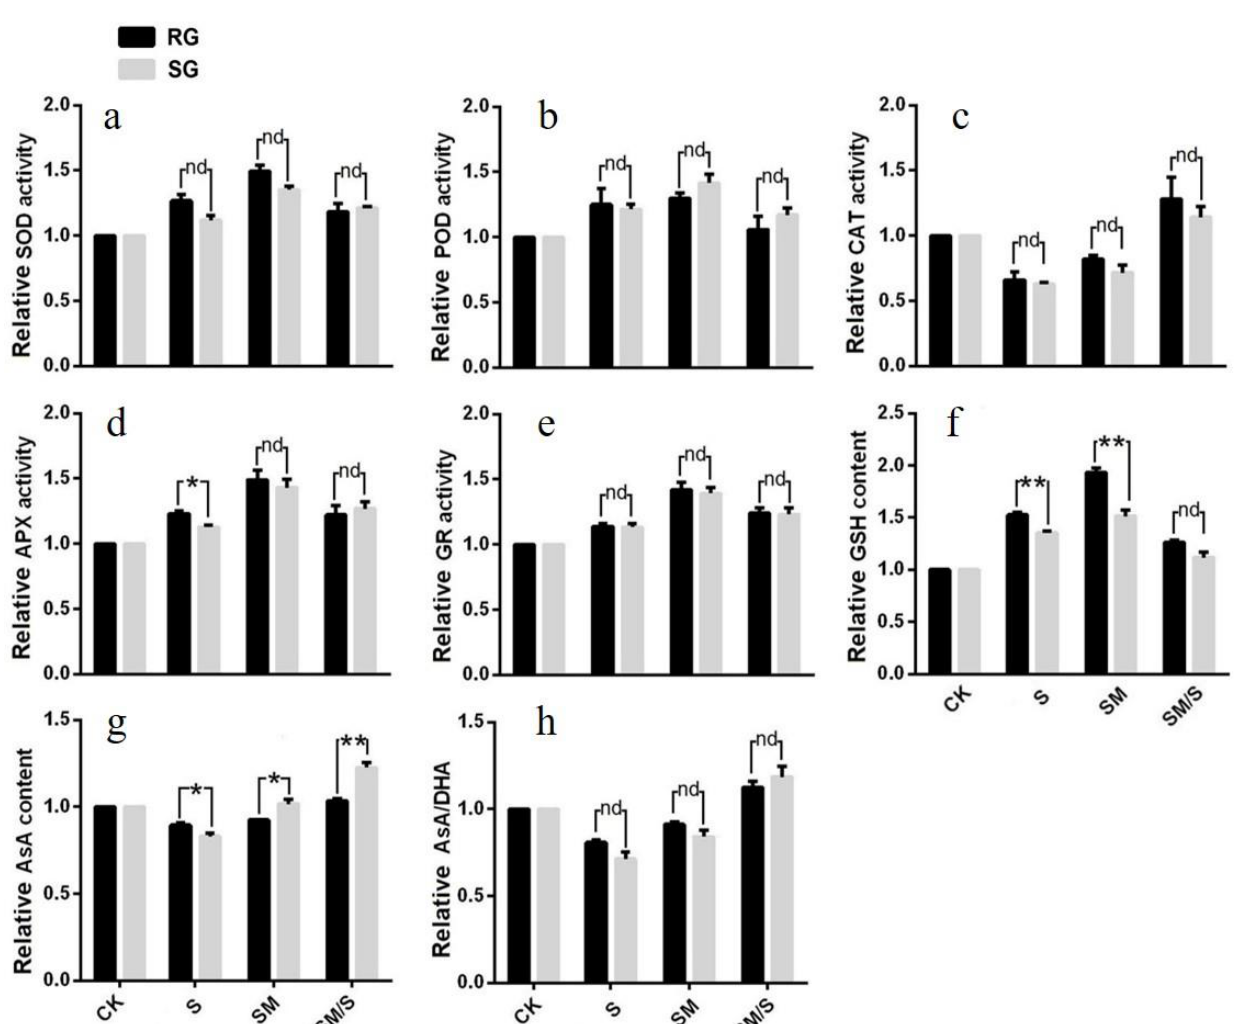
Figure 3. Comparison of antioxidant systems including relative SOD activity ( a ), relative POD activity ( b ), relative CAT activity ( c ), relative APX activity ( d ), relative GR activity ( e ), relative GSH activity ( f ), relative AsA activity ( g ), and relative AsA/DHA ( h ) between salt-resistant and salt-sensitive tomato seedlings under salt stress. All the indices are normalized to CK. RG: salt-resistant genotype; SG: salt-sensitive genotype; CK: 1/2 Garden nutrient solution of Japan (GNSJ) + spraying distilled water; M: GNSJ + spraying 100 µ M melatonin; S: GNSJ-NaCl (containing 200 mM NaCl) + spraying distilled water; SM: GNSJ-NaCl (containing 200 mM NaCl) + spraying 100 µ M melatonin. The asterisk indicates significant difference detected by Student’s t -test ( p < 0.05 marked with * and p < 0.01 marked with **). nd: no difference. Mean ± SE were given (n = 3, biological replications).